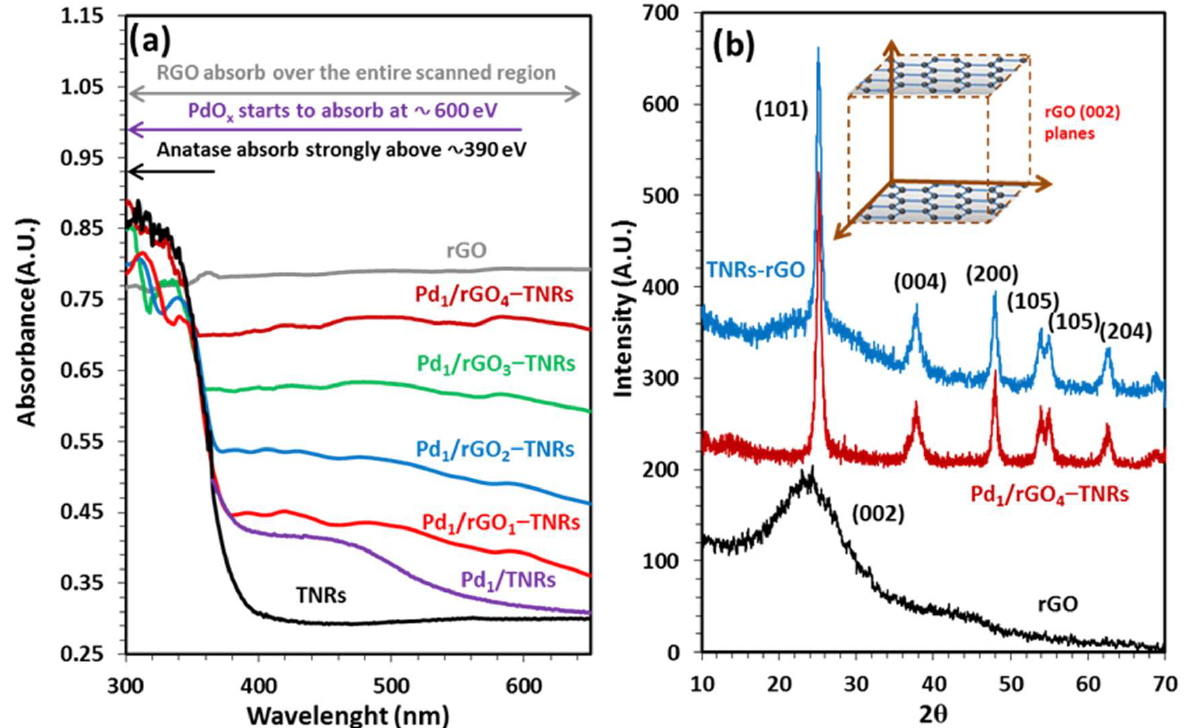
Figure 1. ( a ) Diffused reflectance UV-Visible spectra of as prepared TNR, rGO, Pd 1 /TNRs and Pd x /rGO x −TNRs with different compositions. ( b ) Powder XRD patterns of as prepared rGO, TNRs and Pd 1 /rGO 4 −TNRs.